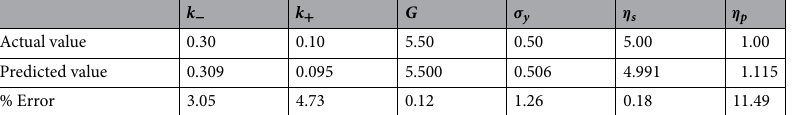
Table 5. RhINNs-predicted values for all coefficients based on 10 different experiments in a start-up of a flow with shear rates ranging between 0.1 and 1 [1/s].